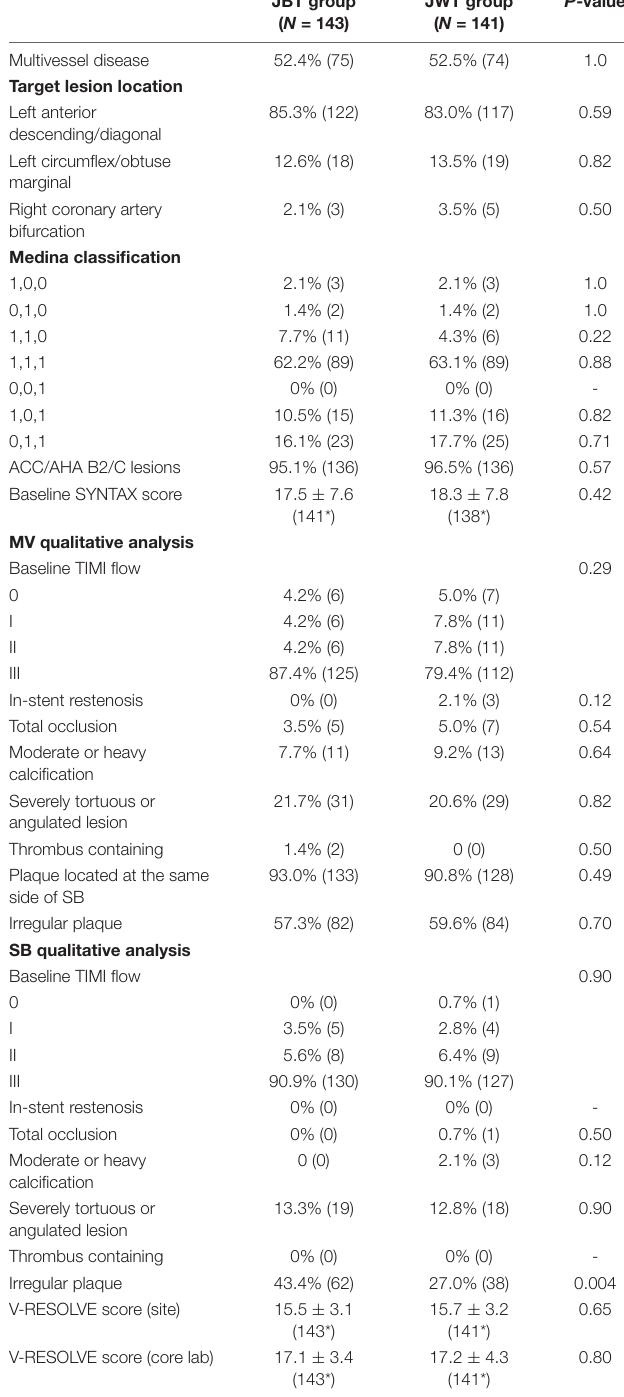
TABLE 2 | Lesion characteristics (intention-to-treat